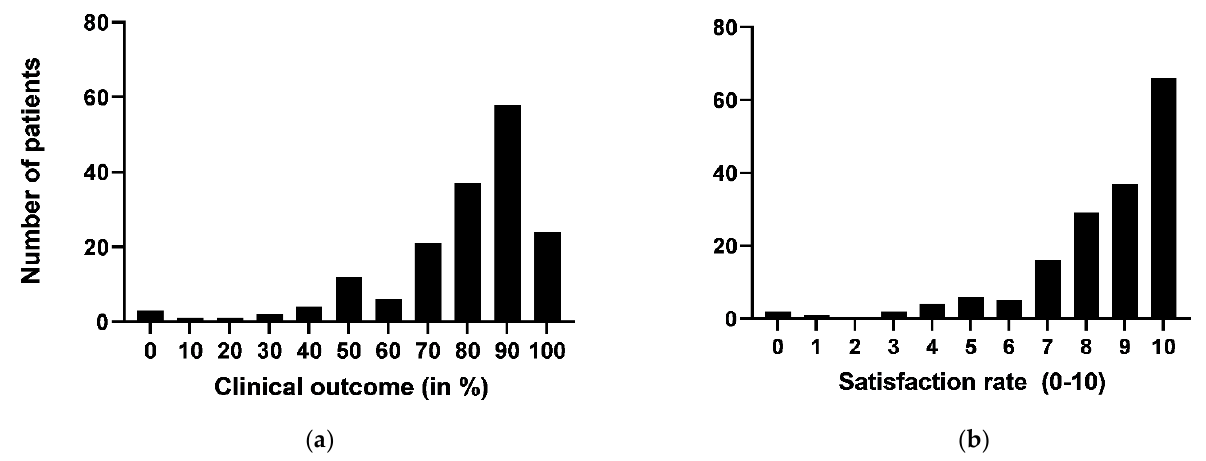
Figure 5. Clinical outcome ( a ) and satisfaction rates ( b ) related to the therapy program (in number of patients). Table 1. Analysis of Spearman correlation coefficient between pain (pre), perceived impact on mental health (pre), age and strength increase with overall clinical outcome and satisfaction rates. (** p < 0.01, *** p < 0.001).